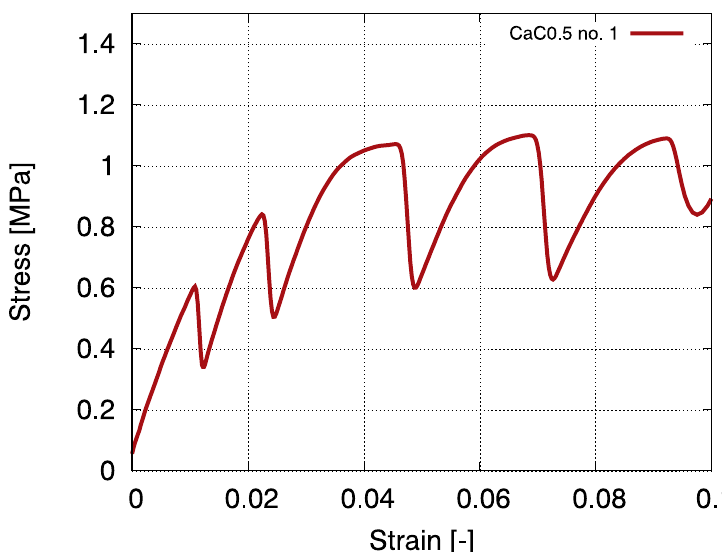
Figure 4. Resulting stress-strain diagram of the time-lapse in-situ investigation performed on a CaCO specimen with 0 . 5 % foaming agent. The first two loading steps were performed with 0 . 6 % strain increment followed by 1 . 2 % steps.